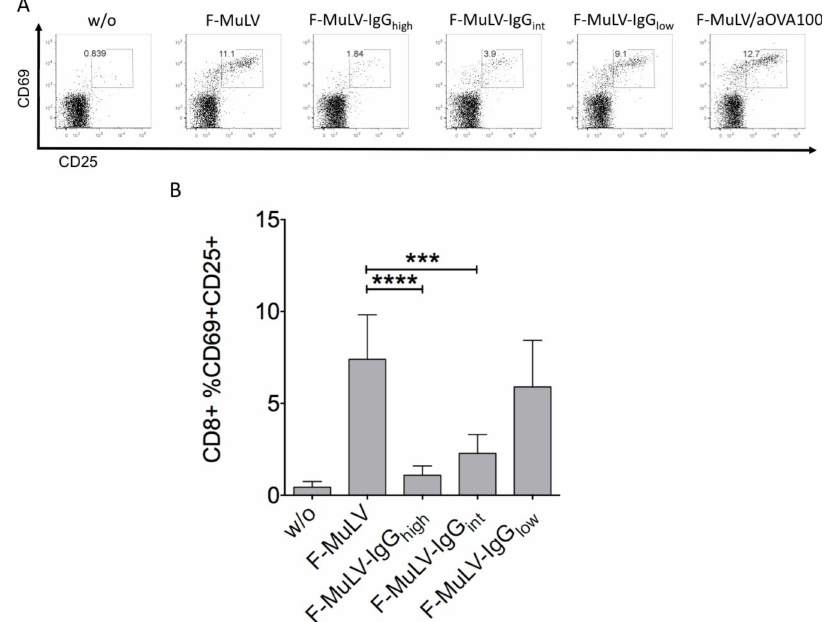
Figure 3. Reduction of CD8 T cell activation was dependent on the concentration of IgG molecules used for F-MuLV opsonization. F-MuLV stocks were opsonized in the presence of 5 µ g/mL (F-MuLV-IgG high ), 0.5 µ g/mL (F-MuLV-IgG int ), or 0.05 µ g/mL (F-MuLV-IgG low ) FV-specific IgG molecules. As a control, F-MuLV was opsonized in the presence of 100 µ g/mL OVA-specific Abs (F-MuLV/aOVA100). 5 × 10 5 DCs were loaded with 5000 FFUs of F-MuLV or IgG-opsonized F-MuLV and cocultured with 5 × 10 5 isolated FV-specific TCRtg CD8 T cells. Activation of CD8 T cells was determined by the expression of CD25 and the early activation marker CD69 gating on AAD-negative living CD8 singlets measured by flow cytometry after 48 hours of coculture. ( A ) A representative experiment and ( B ) mean ± SEM derived from five independent experiments are shown. Data were analyzed by GraphPad PRISM software using ANOVA followed by Dunnet’s multiple comparison test (***, **, * significant at p < 0.001, p < 0.01, p < 0.05,